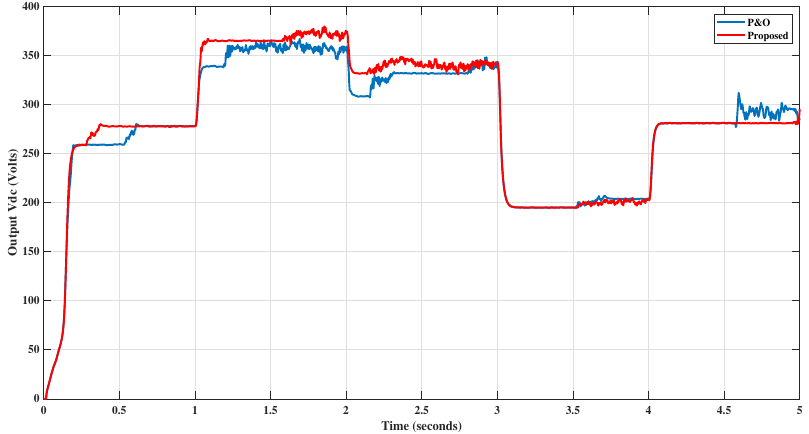
Figure 18. Time and DC voltage.